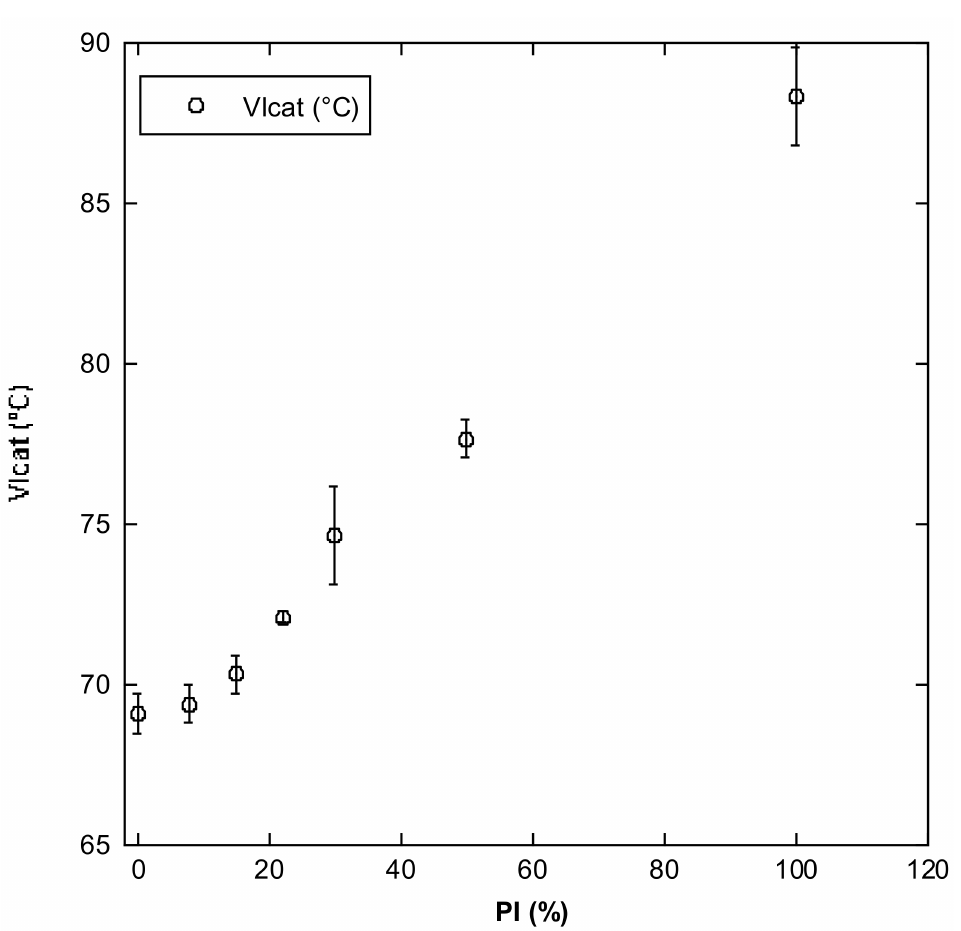
Figure 13. Vicat softening temperature versus post-industrial plastic content.